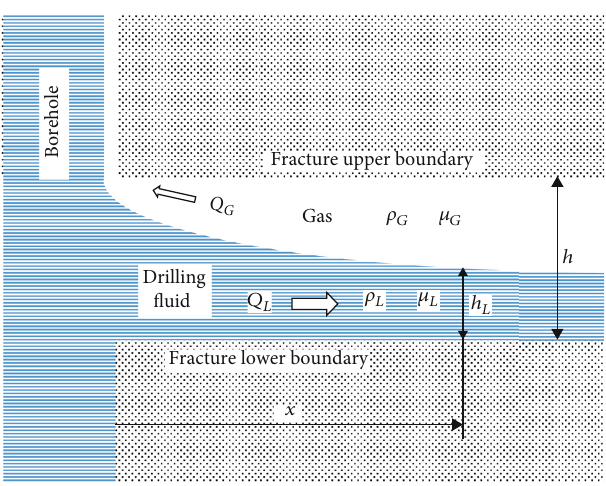
Figure 3: Cross-sectional view of liquid fl ow in a fracture due to gravity displacement.